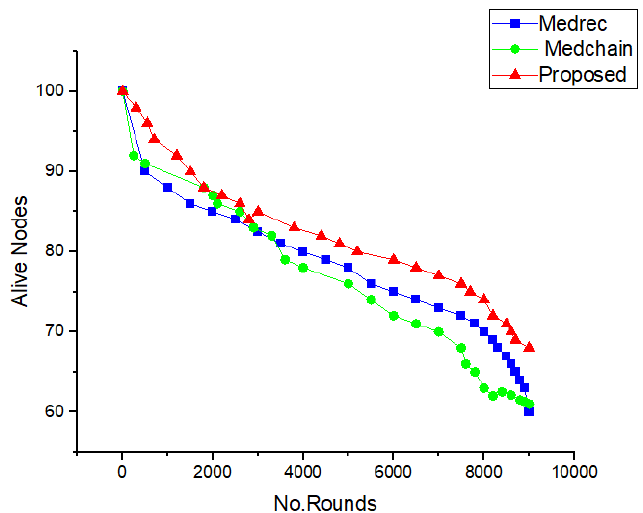
Figure 14. Comparative analysis of live nodes vs. the total number of rounds with the benchmark models (Medrec [49], Medbloc [51]) (0,